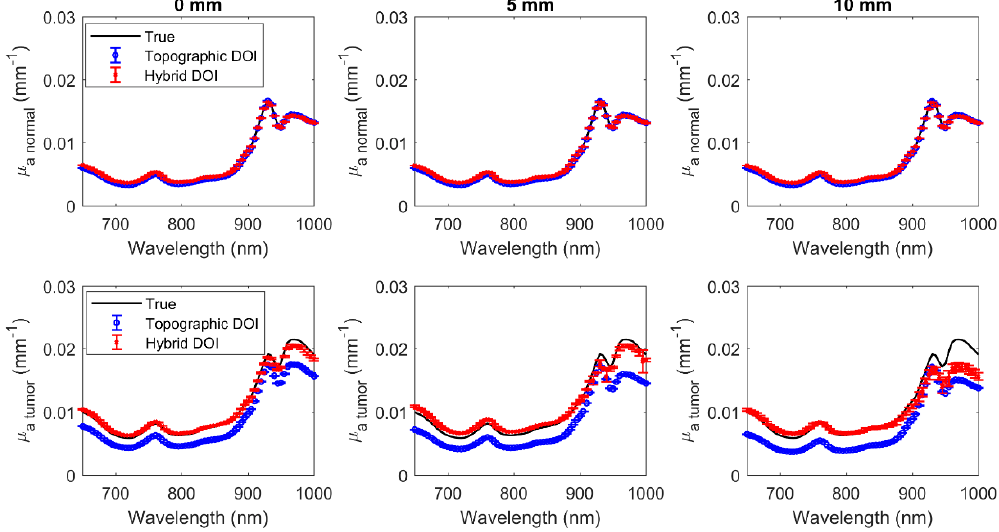
Figure 9. Hyperspectral normal (row 1) and tumor µ a (row 2) at wavelengths 650 nm to 1000 nm at different tumor depths (columns).